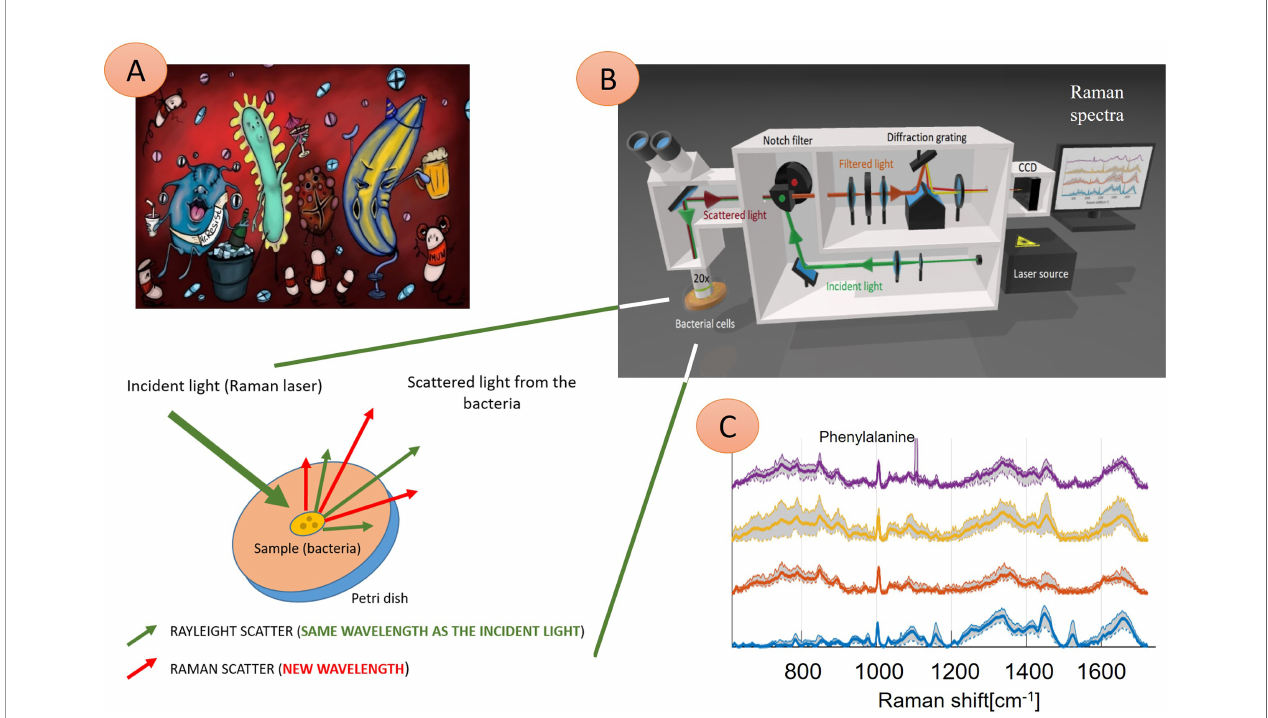
FIGURE 1 | Illustration of four different microbial species interacting with the immune system and their Raman spectra. (A) Microbes are present in the human body, causing an infection. These pathogens can be identi fi ed using Raman spectroscopy technique (B) — here: probing laser (green) is focused on the sample (bacteria), and a small amount of light, which transports the chemical structure of analyzed bacteria, is re fl ected (red) and in the next step further analyzed. Consequently, four Raman spectra (C) show information about molecular bond vibrations of given bacteria, such as phenylalanine at 1005 cm -1 . In this example, the naked eye can see differences between the spectra of four samples. Thus, these pathogens can be identi fi ed quickly (in minutes) to treat infection with tailored antibiotics. (C) Examples of Raman spectra: Staphylococcus pasteuri (violet curve), Staphylococcus warneri (yellow curve), Streptococcus oralis (red curve), Staphylococcus sciuri (blue